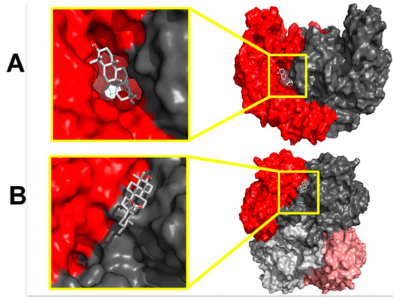
Figure 8. Molecular surface showing the oligomeric interfaces (color-code by chain) and the favored binding sites of triterpenes (Ursolic acid): ( A ) eNOS and ( B ) CSE. The homodimer interface is located along the region where the two monomers, labeled in different colors, connect.